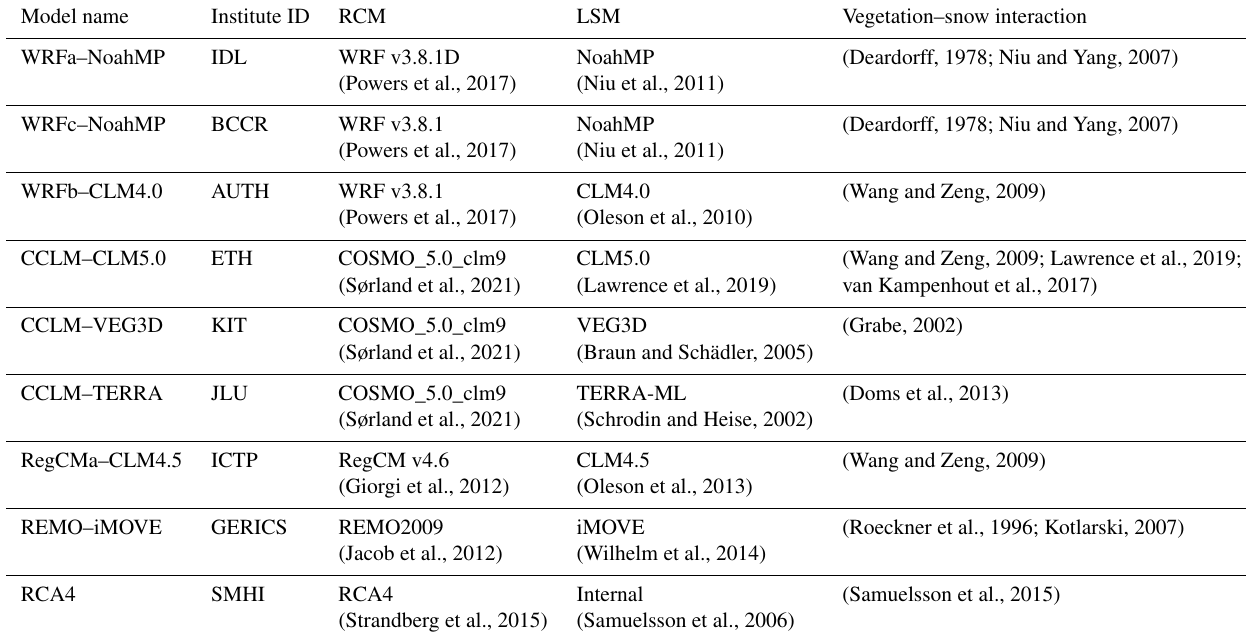
Table 1. A list of the RCMs, LSMs, and the model names used in this study. Also listed are the key references describing the models and the institutions that performed the simulations. Institution and model abbreviations are shown in Appendix